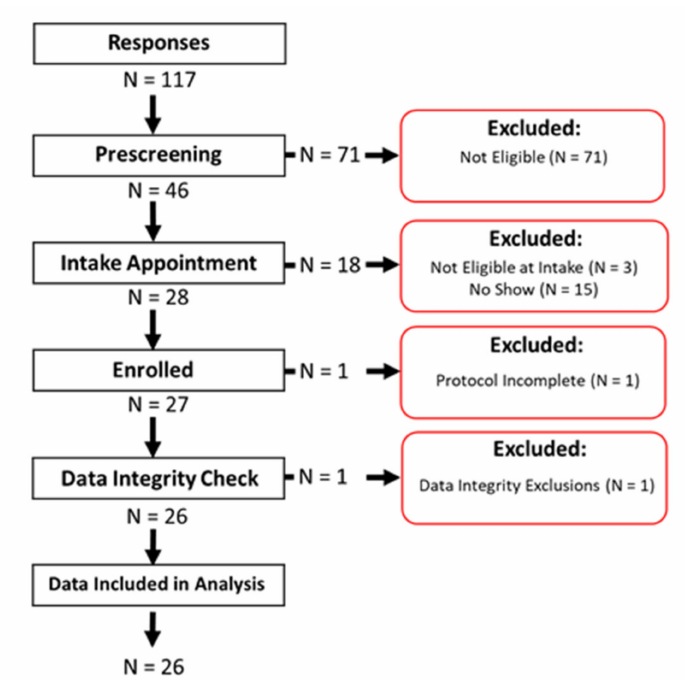
Figure 2. Cohort study flow chart, where n = 117 initial responses were received, n = 46 respondents were found eligible and invited to an intake appointment, and n = 28 participants were